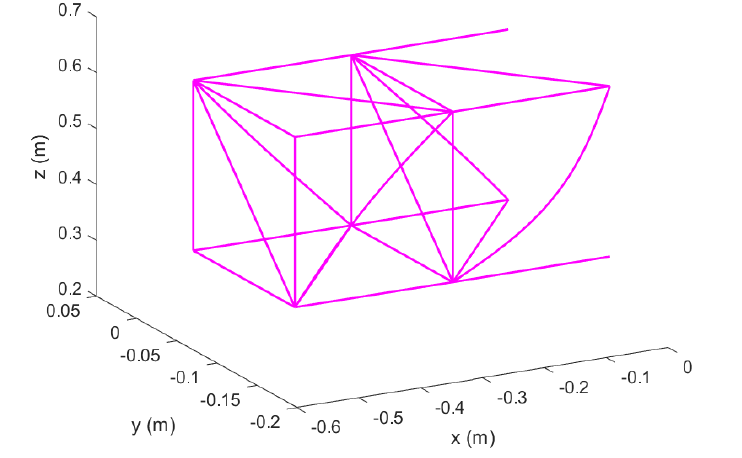
Figure 22. Mode 5 of Euler–Bernoulli Beams in Topology 1 with hinged ends; original configuration.